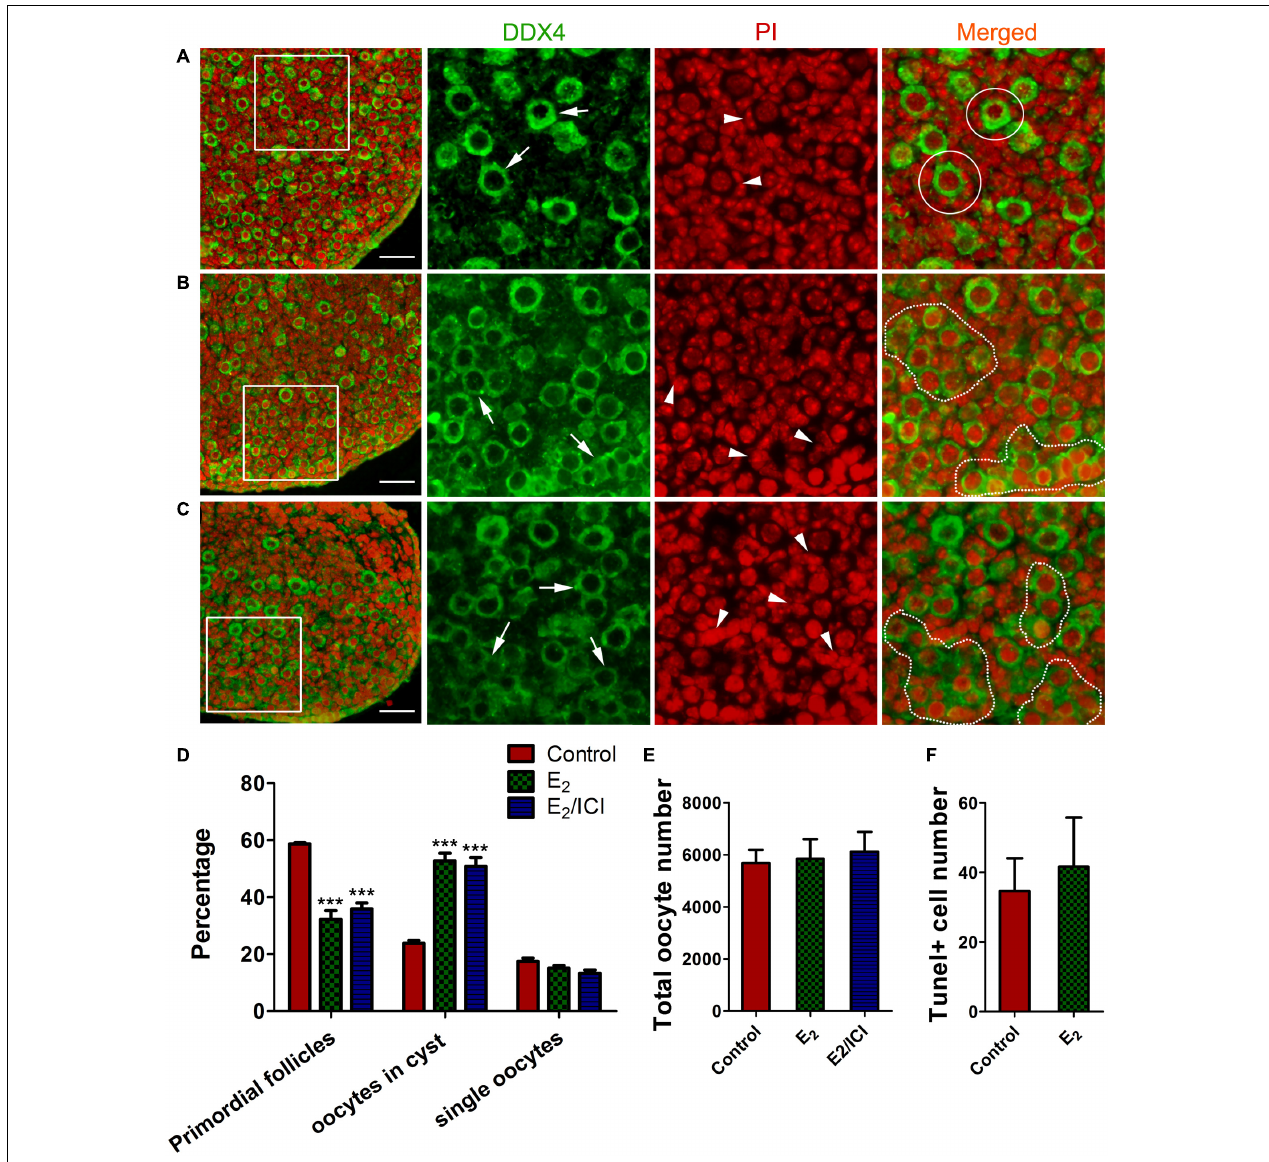
FIGURE 7 | E 2 -delayed meiotic prophase I impairs primordial follicle assembly. Sections from control group (A) , E 2 group (B) and E 2 + ICI 182,780 group (C) were stained with DDX4 (green) to visualize oocytes and PI (red) to visualize nucleus. Framed area was enlarged. Arrow: oocyte, arrowhead: pregranulosa cell, White circle: primordial follicle, dotted line: germ-cell cyst. Scale bar, 40 µ m. Counting analysis for primordial follicles assembly (D) , total oocytes (E) and TUNEL-positive oocytes (F) . *** P <